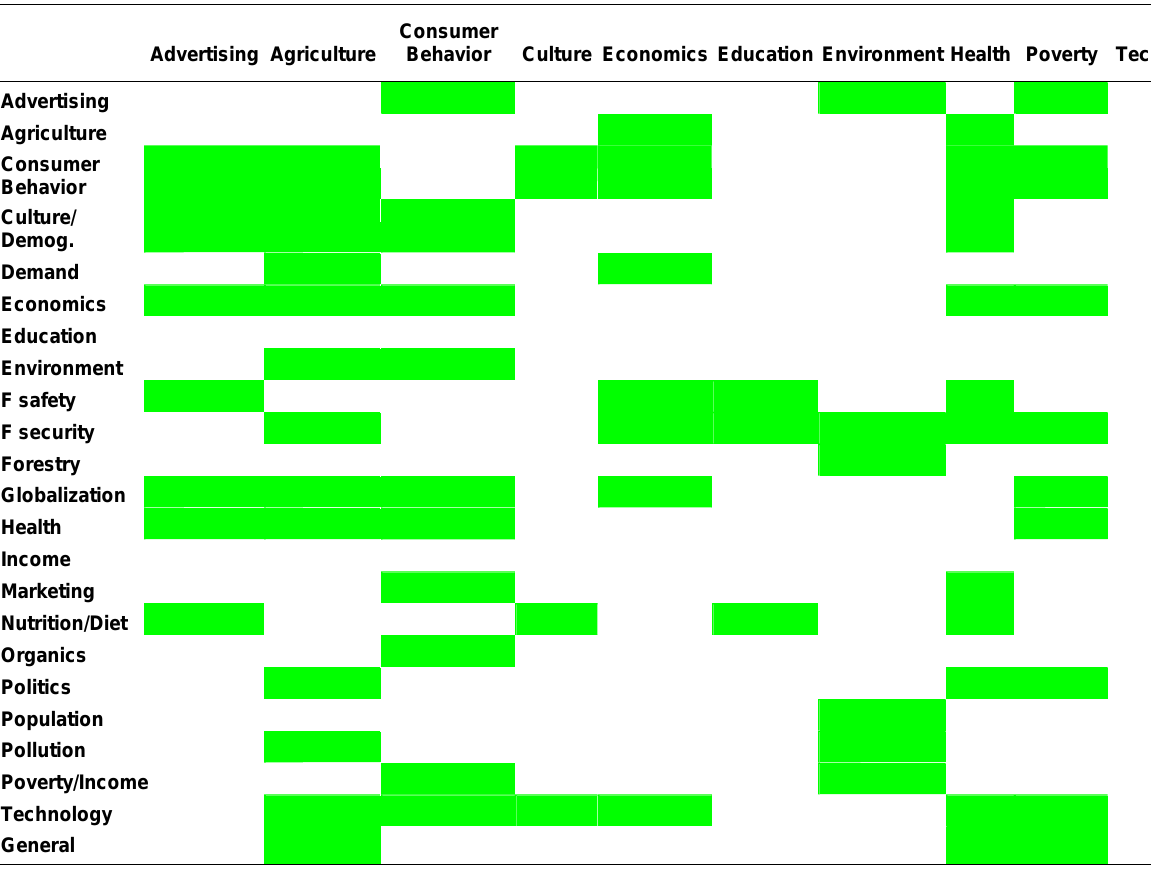
Literature-Derived Relationship Between the